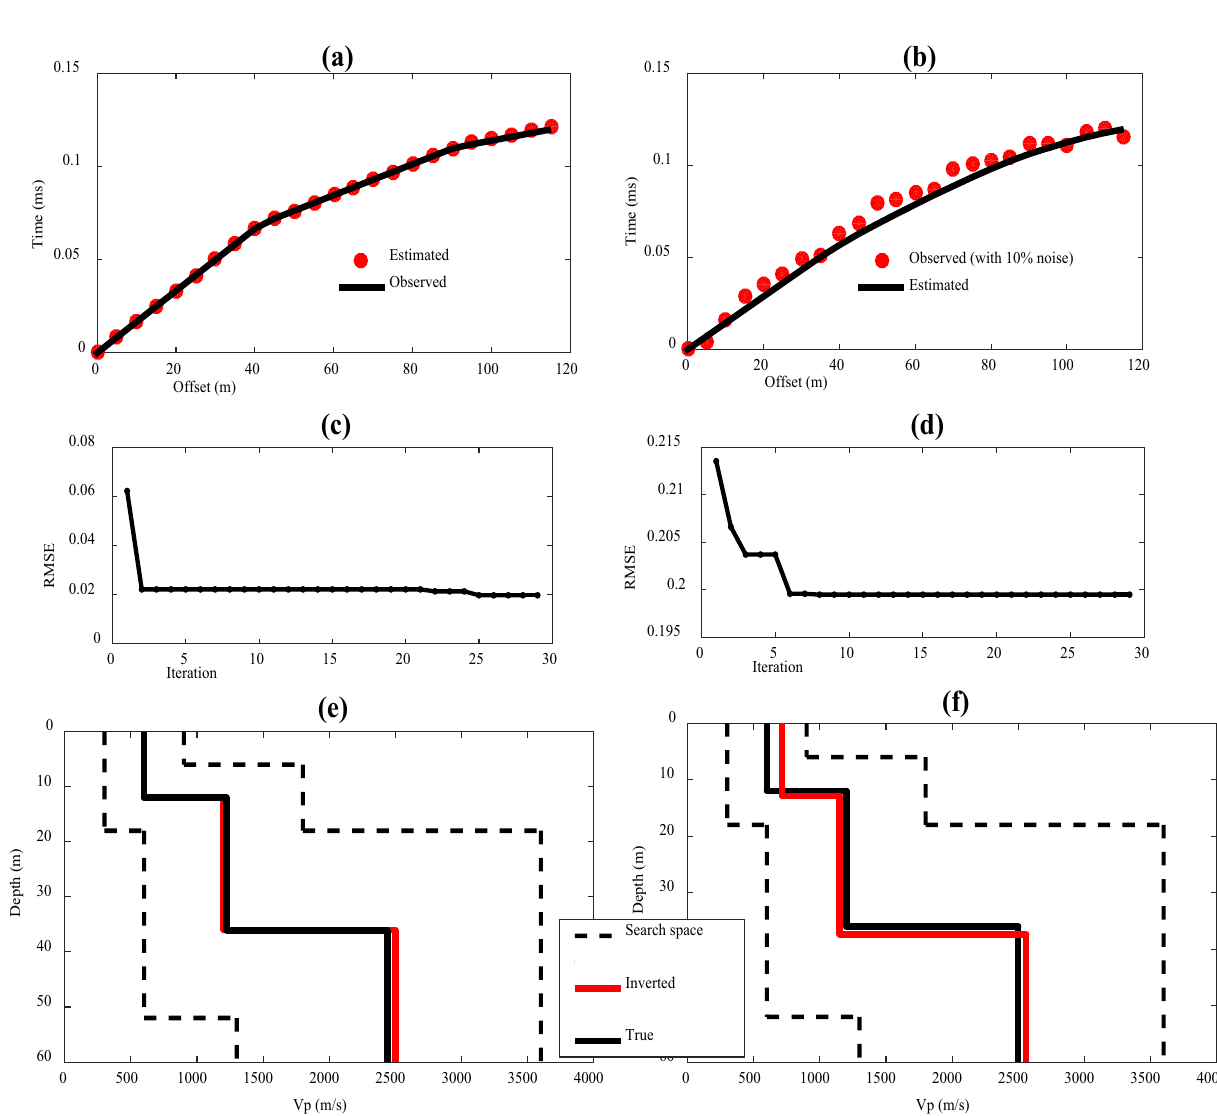
inversion of model, respectively, without noise and in the presence of 10% noise, e the modeled Vp profile (the red line) by the inver- sion of model A (without noise), f the modeled Vp profile (the red line) by the inversion of model A in the presence of 10%